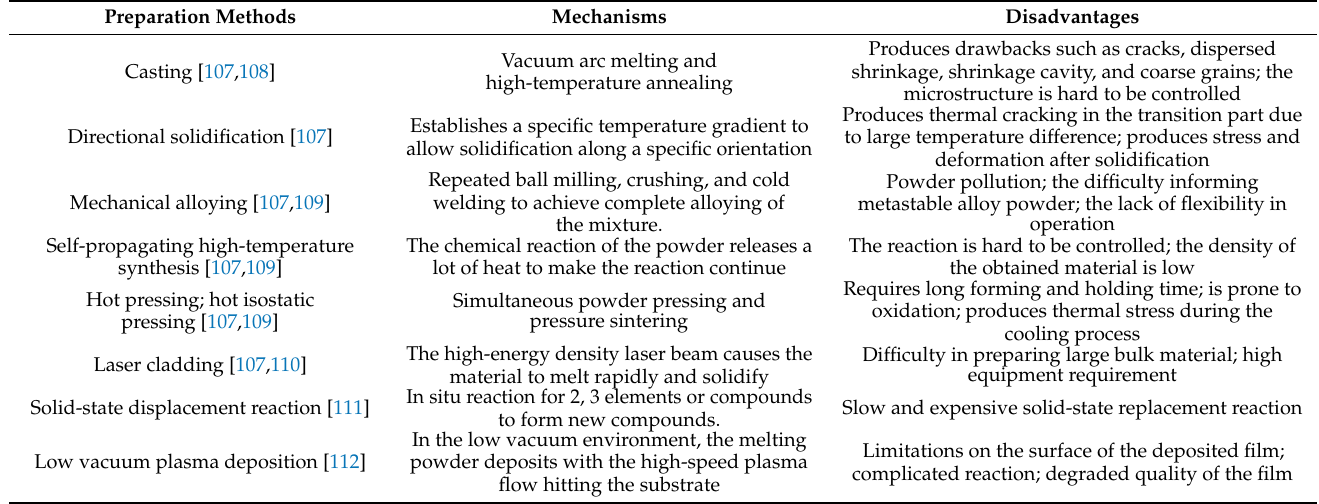
Table 9. The preparation process of Mo-Si-based